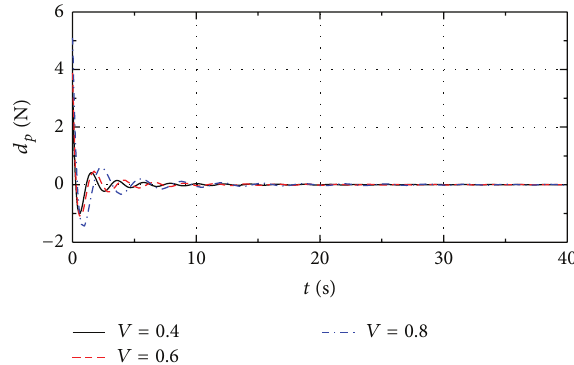
Figure 5: The difference between the analytical and asymptotical contact forces.